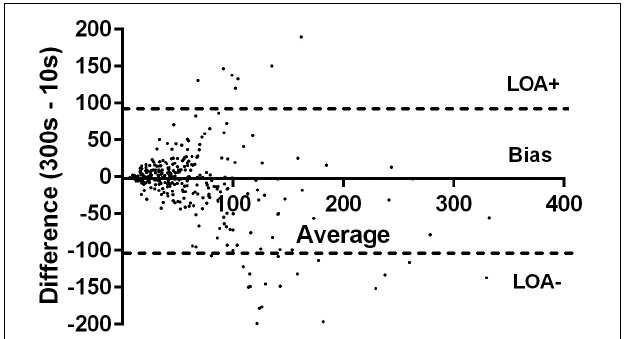
FIGURE 1 | Modified Bland–Altman relative-differences analysis comparing 10 vs. 300 s RMSSD value showing median differences in 10 vs. 300 s and the limits of agreements (LOA) and their 95% confidence